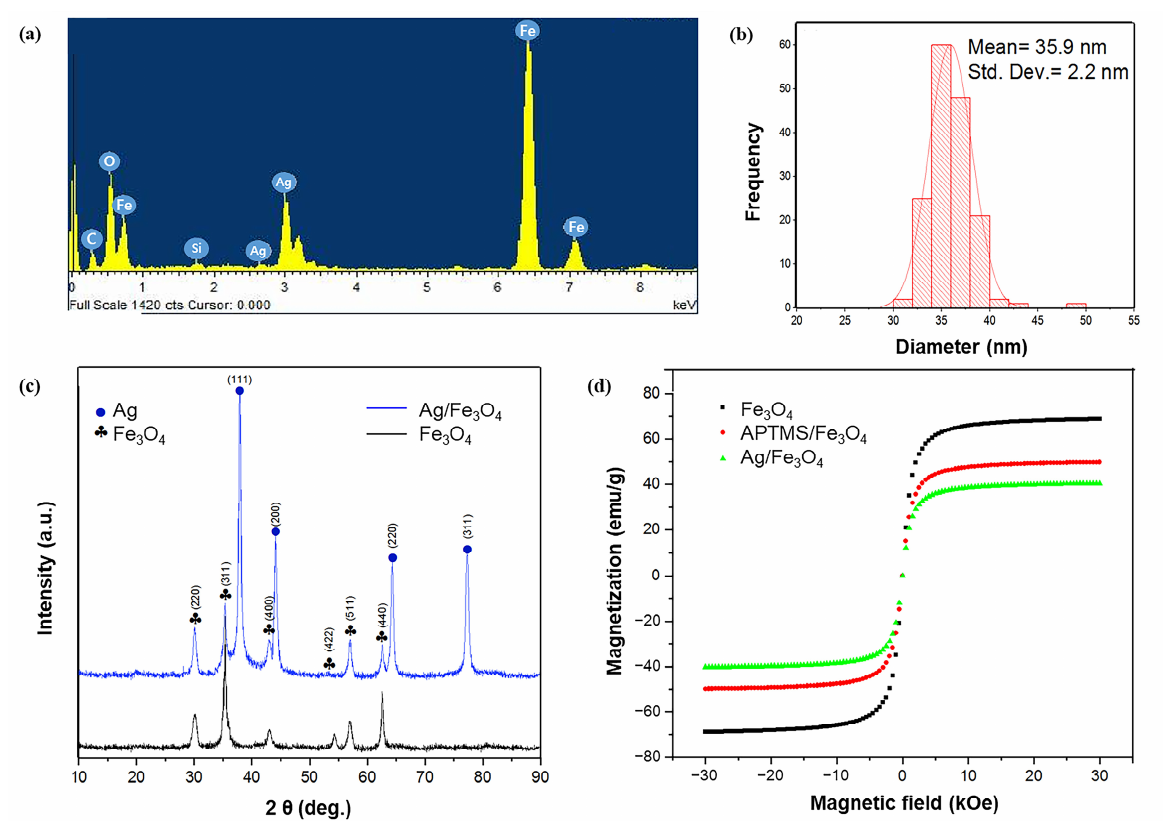
Figure 3. Characterization of the nanomaterials. ( a ) EDS spectrum of the Ag/Fe 3 O 4 nanocomposites; ( b ) size-distribution histogram of the Ag/Fe 3 O 4 with a standard deviation of 2.2 nm; ( c ) XRD analysis of the Fe 3 O 4 and Ag/Fe 3 O 4 ; ( d ) magnetic hysteresis loops of Fe 3 O 4 , APTMS/Fe 3 O 4 , and Ag/Fe 3 O 4 nanocomposites at room